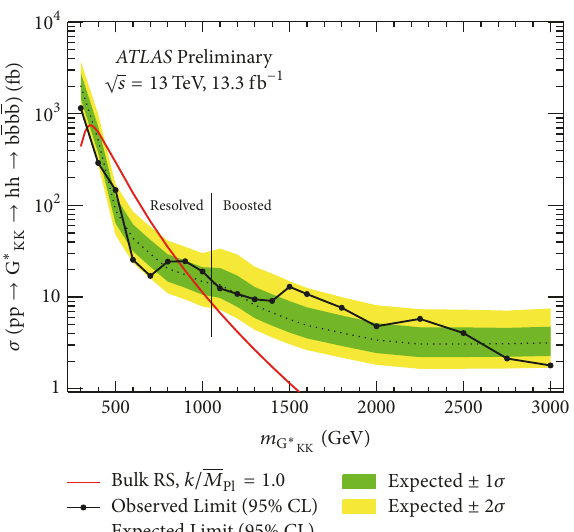
Figure 7: The expected and observed upper limit for pp → 𝐺 KK → ℎℎ → 𝑏𝑏𝑏𝑏 in the bulk RS model with 𝑘/𝑀 = 1 at the 95% confidence